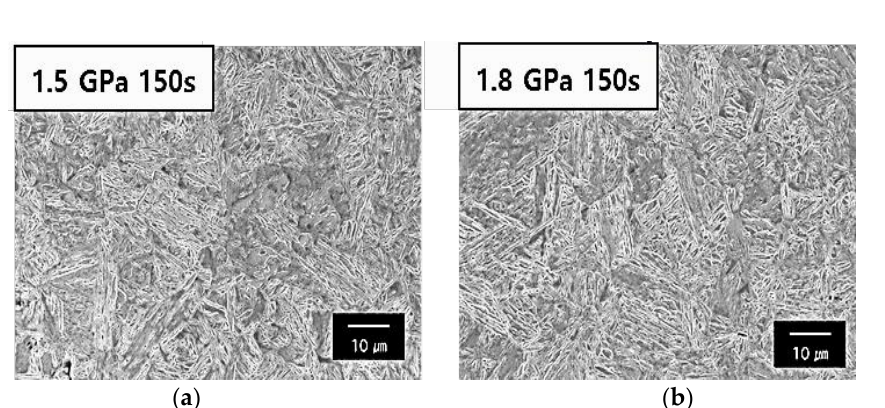
Figure 2. SEM images of martensitic phase: ( a ) the 1.5 GPa grade steel austenitized for 150 s at 1203 K and ( b ) the 1.8 GPa grade steel austenitized for 150 s at 1203 K. Table 3. The values of parameter from strain–stress curves.